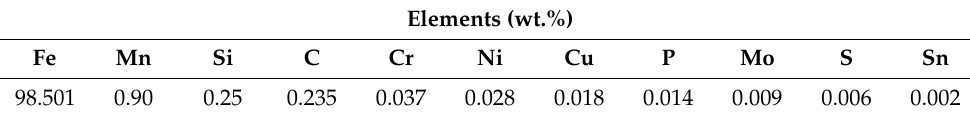
Table 1. Chemical composition of steel rebar.